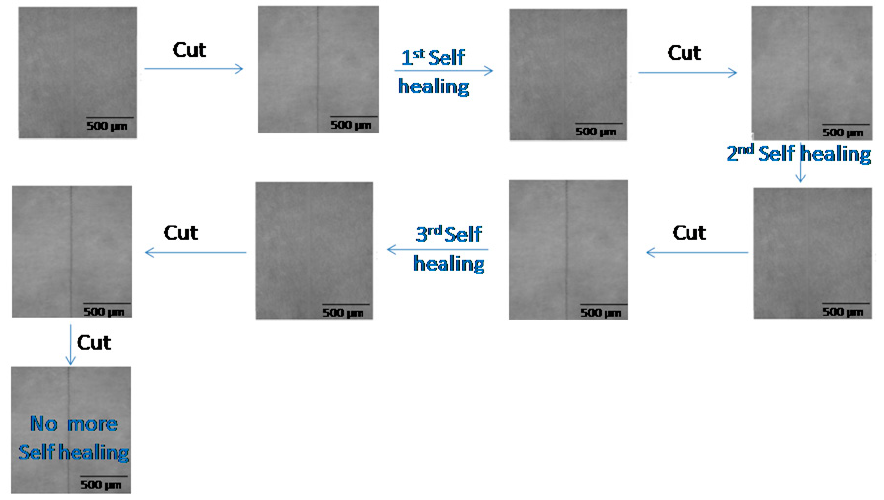
Figure 3. Self-healing of PU-11-3-3 coating.